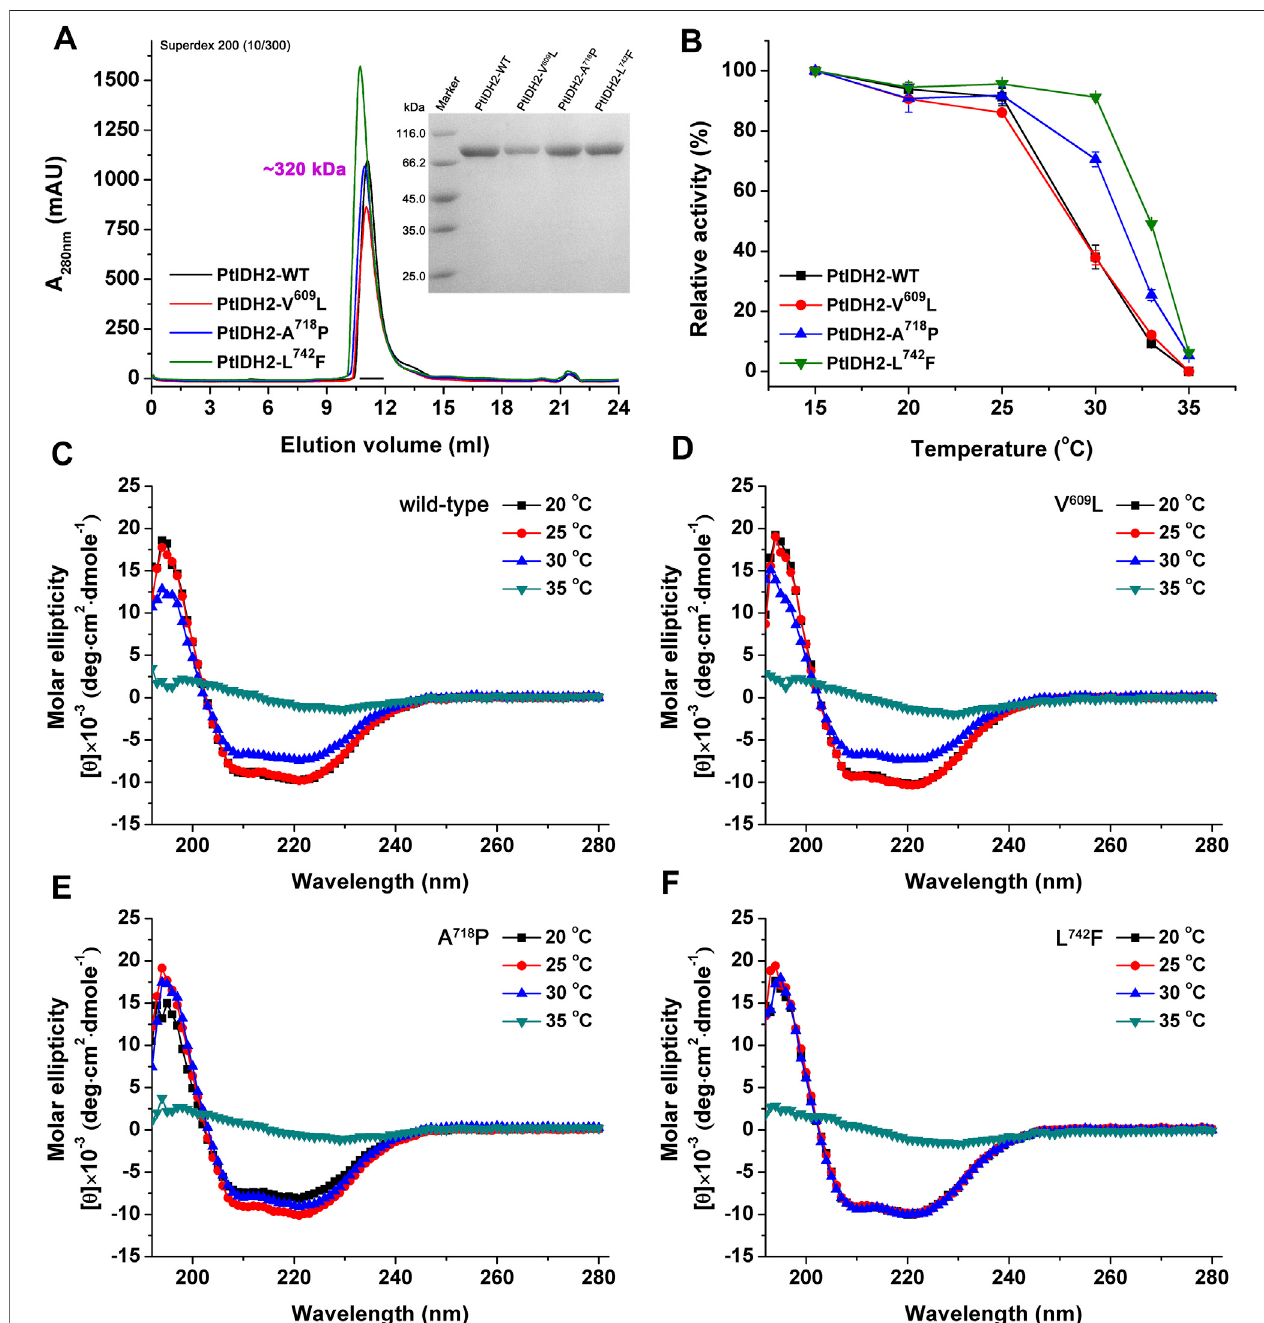
FIGURE 5 | Overexpression and puri fi cation of mutated PtIDH2. (A) Overexpression, puri fi cation, and determination of the oligomeric state of mutated PtIDH2. Size-exclusion chromatography elution pro fi les of mutant forms of PtIDH2 obtained using a Superdex 200 (10/300) column at a fl ow rate of 0.5 ml/min. The right inset panel shows the protein purity detection by 12% SDS – PAGE. (B) Heat-inactivation pro fi les of the wild-type and mutated forms of PtIDH2. All values are displayed as means ± SD of at least three independent measurements. (C) CD spectra of four states of wild-type PtIDH2. The individual enzymes were incubated for 20 min at 20,25,30,and35 ° C,respectively. (D) CDspectraoffourstatesofV 609 L.Theindividualenzymeswereincubated for20 minat20,25,30and35 ° C,respectively. (E) CD spectra of four states of A 718 P. The individual enzymes were incubated for 20 min at 20, 25, 30 and 35 ° C, respectively. (F) CD spectra of four states of L 742 F. The individual enzymes were incubated for 20 min at 20, 25, 30 and 35 ° C,